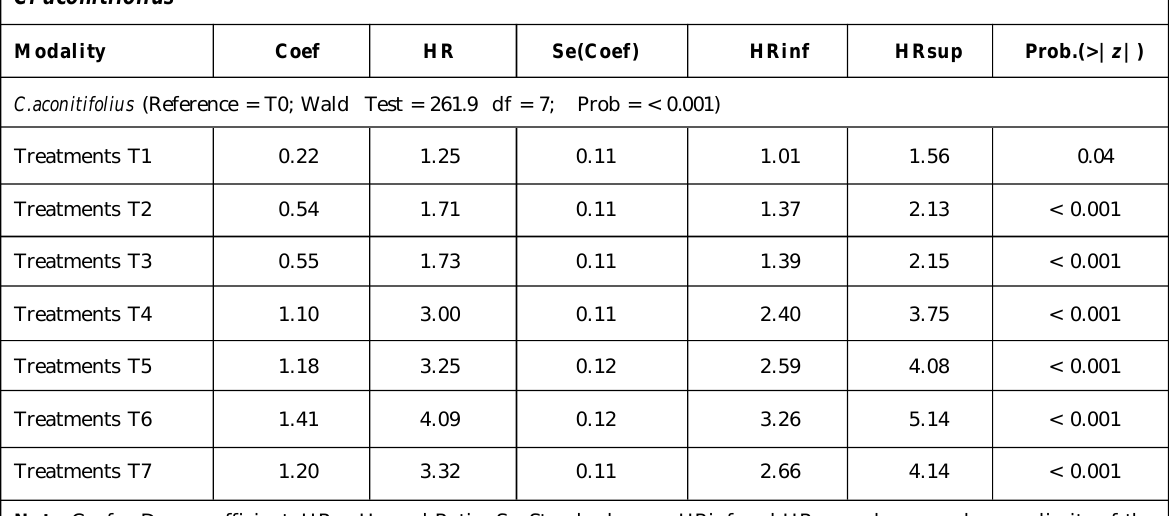
Table 1 : Result of cox model applied to mortality rate of C. maculatus under the effect of powder of C. aconitifolius